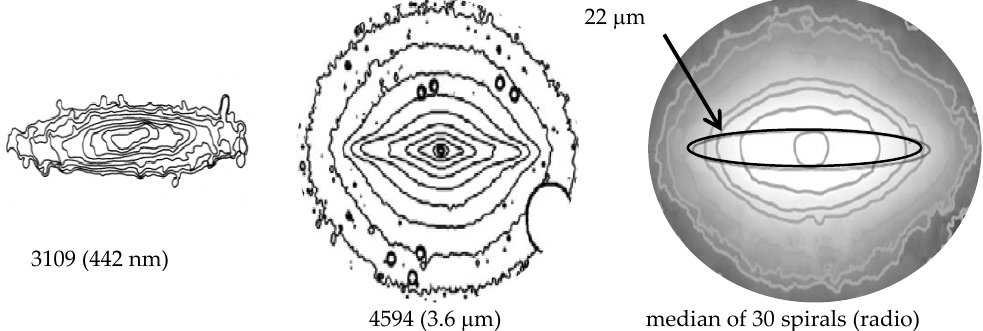
Figure 2. Isophotes of edge-on galaxies at various wavelengths: (left) New General Catalog (NGG) 3109 in the B-band. Modified after figure 6 in Carignan, C. 1985 , Light and mass distribution of the magellanic-type spiral NGC 3109. Astrophys. J. 299 , 59–73 [24] with permissions; (middle) NCG 4594 (Sombrero) isophotes at 3.6 µ m (circles are foreground stars). Modified after figure 1 in Gadotti, D.A. and S á nchez-Janssen, R. 2012 , Surprises in image decomposition of edge-on galaxies: Does Sombrero have a (classical) bulge? Mon. Not. R. Astron. Soc. 423 , 877–888 [26], with permissions from Oxford University Press on behalf of the R. Astron. Soc.; (right) Grey shades = the L-band from averaging 30 spirals, using the 22 µ m contour to represent the disk. Modified after figure 6 in [21] (Wiegert, T. and 9 others, 2015 . CHANG-ES. IV. Radio continuum emission of 35 edge-on galaxies observed with the Karl G. Jansky very large array in D configuration—Data release 1. Astron. J., 150:81, doi:10.1088/0004-6256/150/3/81), with permissions.